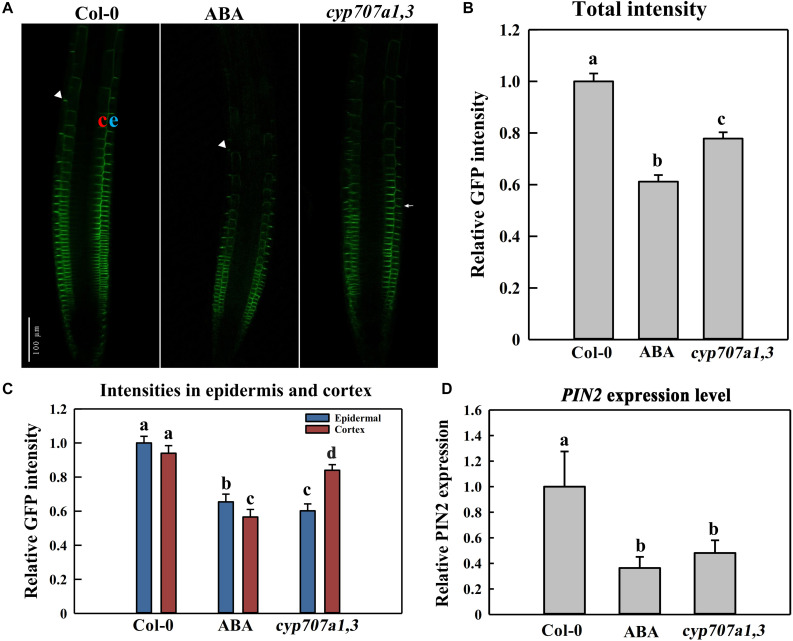
PIN2 abundance and distribution in the control Col-0, ABA-treated WT (Col-0) and cyp707a1,3 double mutant. (A) Representative confocal images of PIN2-GFP in Col-0, ABA-treated WT and cyp707a1,3. For ABA-treated WT (middle panel), 5-day-old PIN2-GFP/Col-0 seedlings were treated with 8 μM ABA for an additional d. For Col-0 and cyp707a1,3 (left and right panels, respectively), 5-day-old seedlings were transferred onto 1/2 MS medium 1-day before confocal microscopy observations. (B) Relative total intensity of PIN2-GFP in different lines or treatments was as described in panel (A). Total PIN2-GFP intensities refer to the GFP intensity on the membrane (outlined automatically with the same threshold) and were normalized to PIN2-GFP/Col-0. (C) PIN2-GFP distribution in the epidermis and cortex of different lines or treatments was as described in panel (A). Intensities in each layer of all trials refer to the membrane intensities and were normalized to the epidermal PIN2-GFP intensity of PIN2-GFP/Col-0. (D) Relative PIN2 expression level in the root of the control Col-0, ABA-treated Col-0 and cyp707a1,3. Col-0 and ABA represent 5-day-old Col-0 seedlings treated without (Col-0) or with ABA. cyp707a1,3 was transferred onto 1/2 MS-free medium. Following 1-day treatments in the new medium, PIN2 expression level in the root tip was analyzed by qRT-PCR. The expression level was normalized to WT (Col-0). Each bar represents the mean of 3 biological samples and 3 technical replicates. For the histograms of panels (B,C), each bar represents the mean of 30 independent measurements ± SE. For panels (B–D), the adjacent letters denote the significance levels.